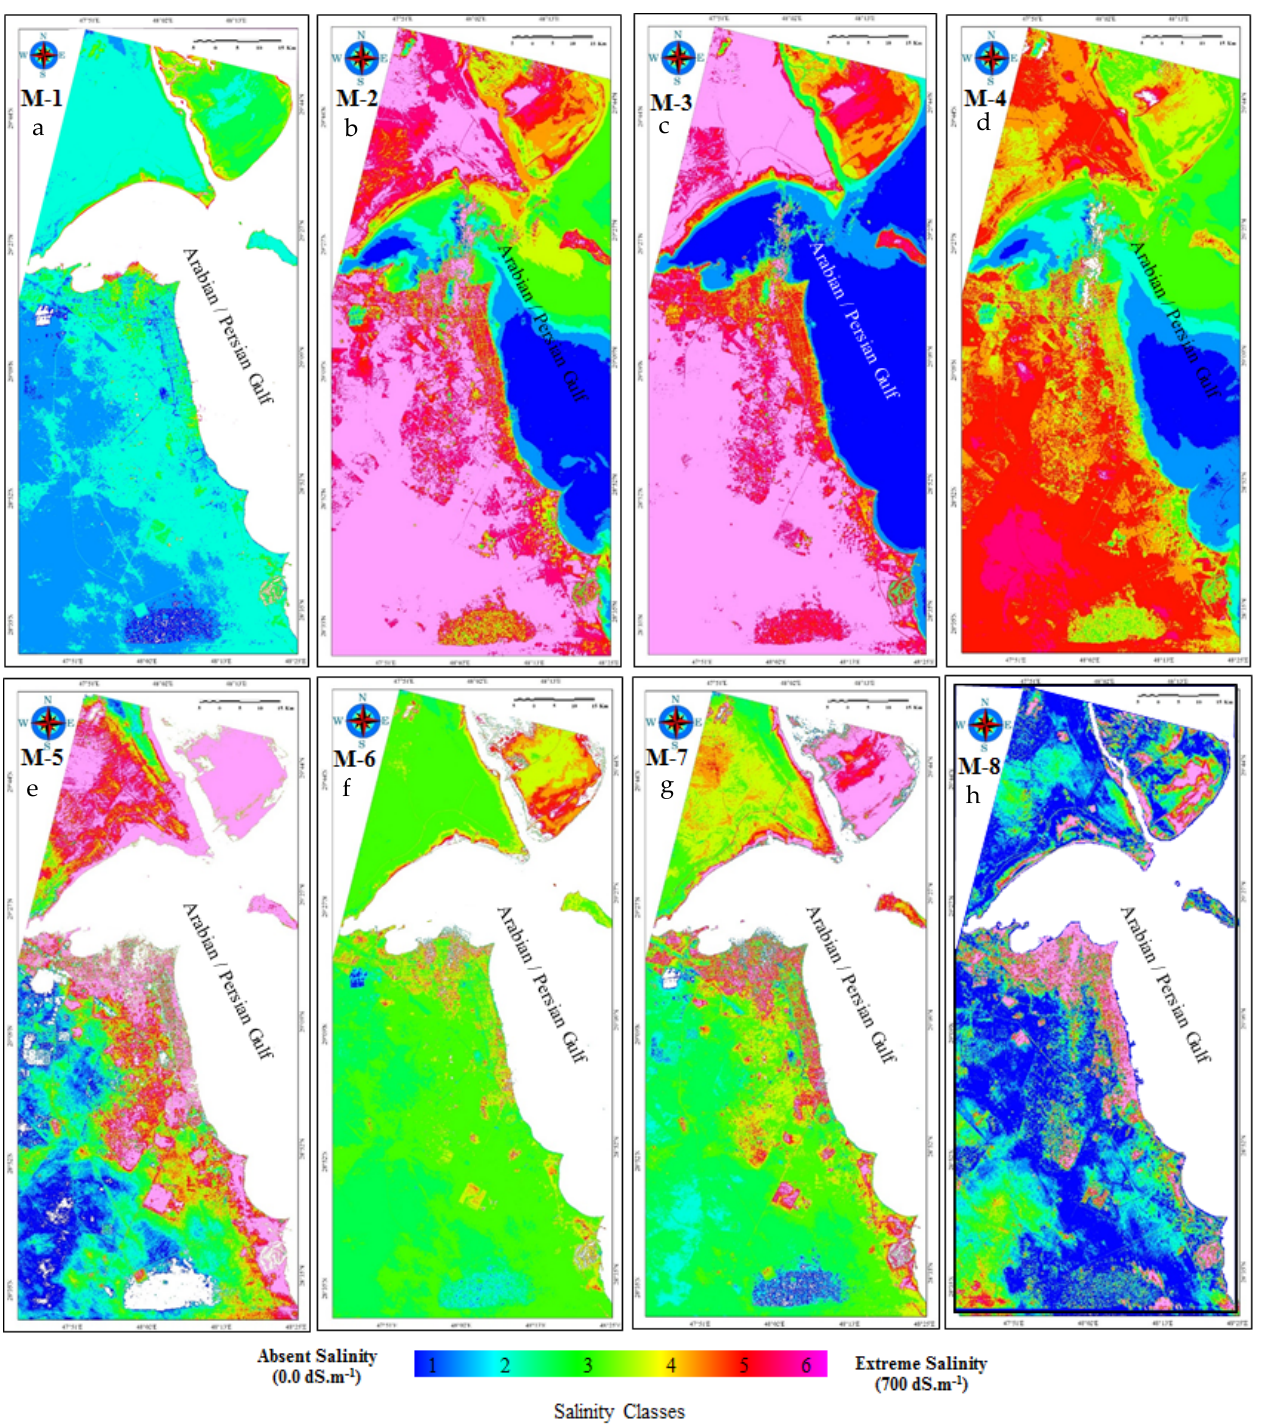
Figure 8. Derived soil salinity maps applying eight models.